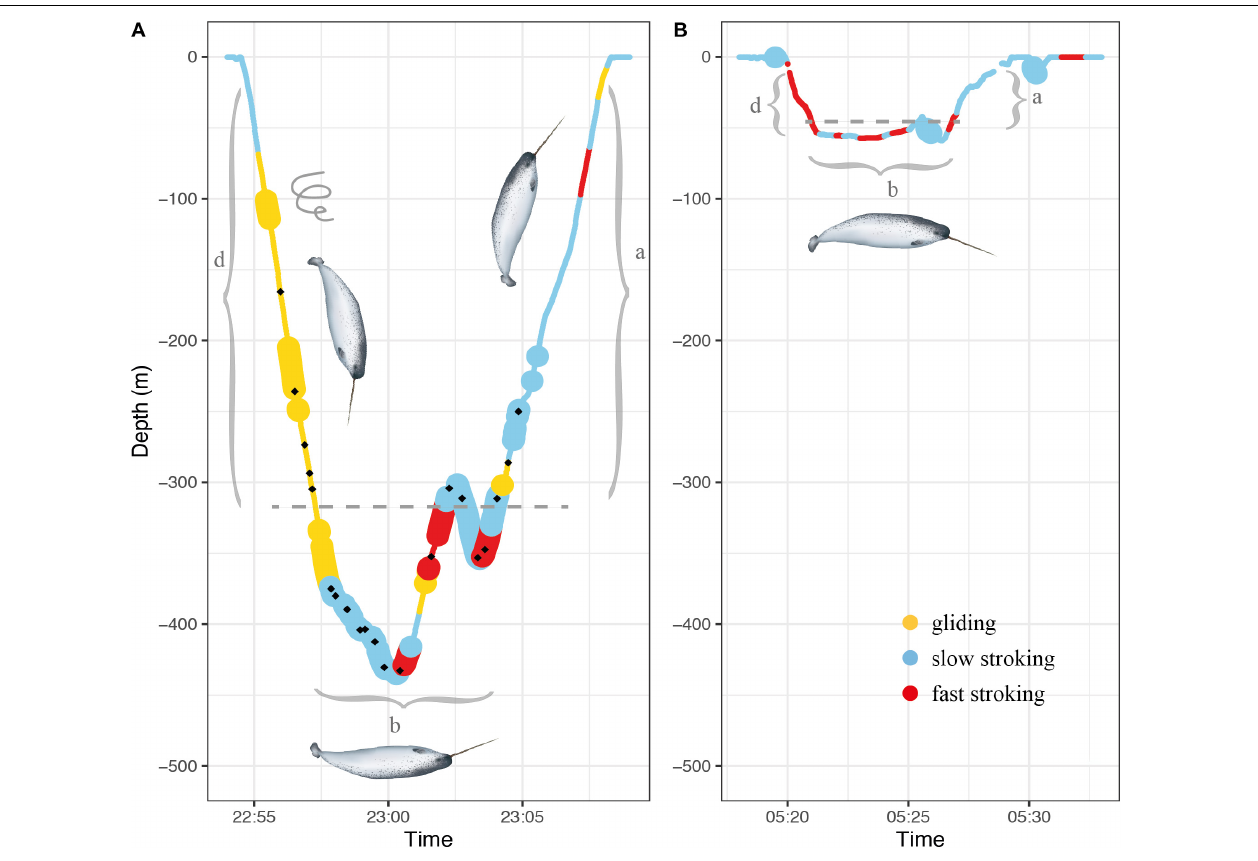
FIGURE 2 | Examples of dive profiles of a foraging V dive (A) and non-foraging U dive (B) . The gray brackets mark the different dive phases descent (d), bottom phase (b) and ascent (a). The dashed gray line on both graphs mark the depth threshold (75% maximum depth) used for determining bottom phase. The different colors represent the three stroking modes while large-size markers indicate spins. The black dots in panel A denote buzzes. Illustration of narwhal by Uko